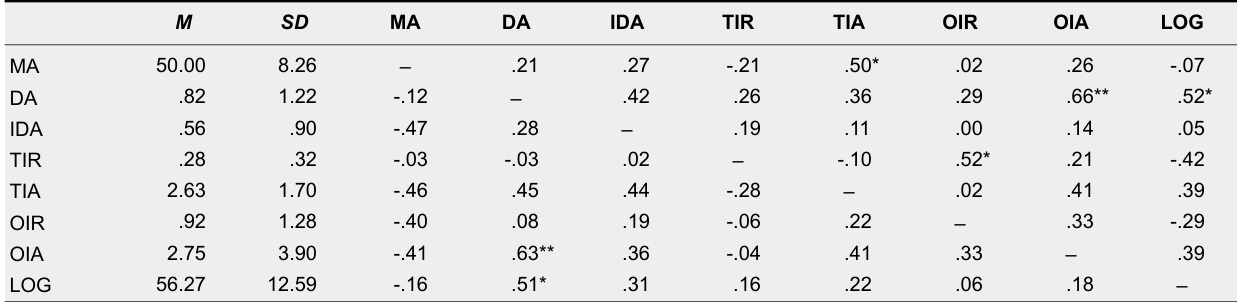
Mean Proportion of Time Engaged in Each Behaviour and Correlations Between Machiavellianism and the Behavioural Measures for Boys and Girls LOGOIAOIRTIATIRIDADAMA